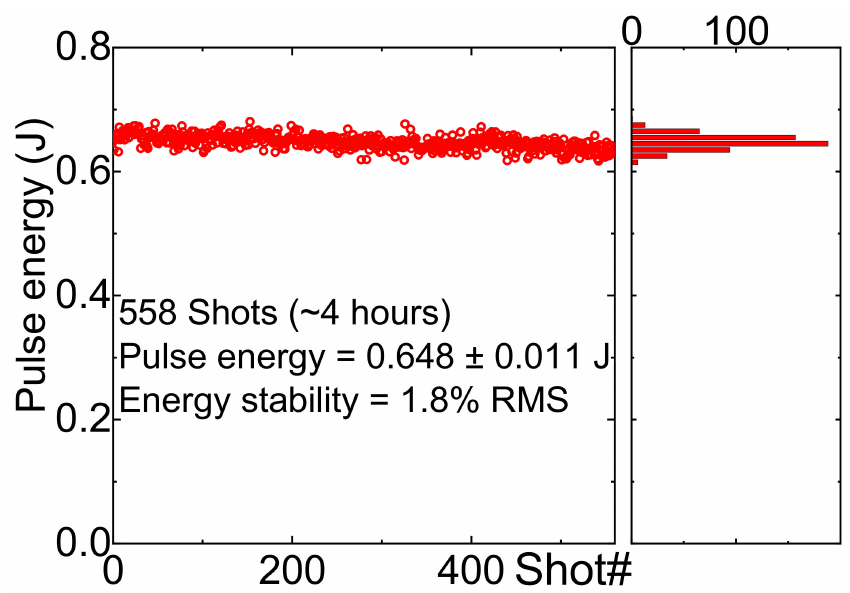
Figure 6. J-KAREN laser pulse energy stability during one day of an experiment (power amplifier mode, 4 h of operation). The pulse energy is calculated from the absolutely calibrated spectrum of the full-diameter beam.